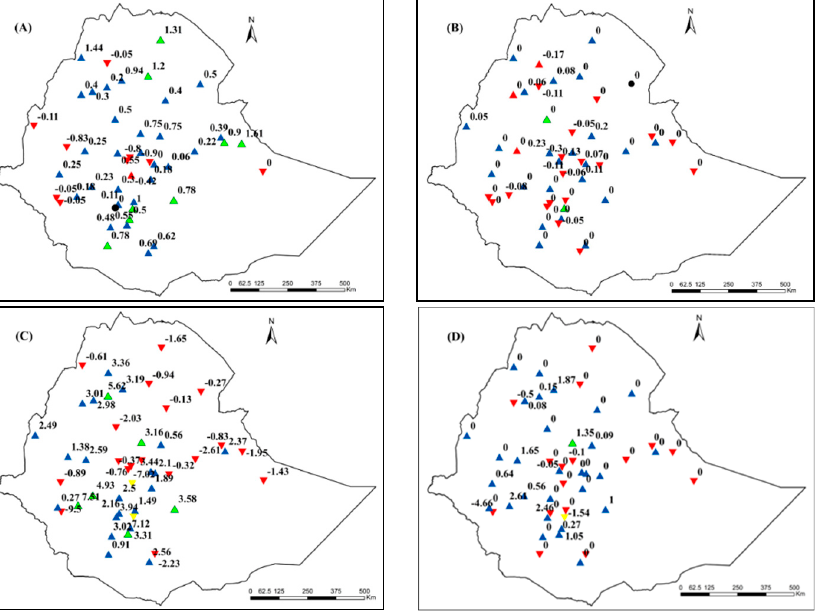
Figure 3. Spatial distributions of trends of the extreme rainfall indices over Ethiopia for the long-term period between 1986 and 2020: ( A ) CDD, ( B ) CWD, ( C ) R95p, and ( D ) R99p. Note: Filled blue upright and filled red inverted triangles indicate increasing and decreasing trends, respectively, while circles filled in black indicate no trend. Significantly increasing and decreasing trends are symbolized by filled green upright triangles and filled yellow inverted triangles, respectively. Insignificant trends are represented by filled upright and inverted triangles.